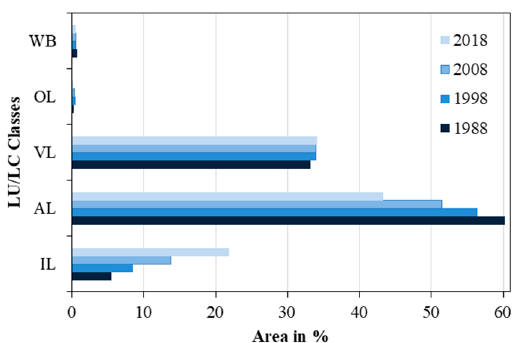
Figure 2. Spatial dynamics of Land Use/Land Cover (LULC) in Kathmandu, ( a ) 1988; ( b ) 1998; ( c ) 2008; ( d ) 2018. Square box transect over all LULC maps (a–d) is to show the effects of Agriculture land on land surface temperature (LST) dynamics.